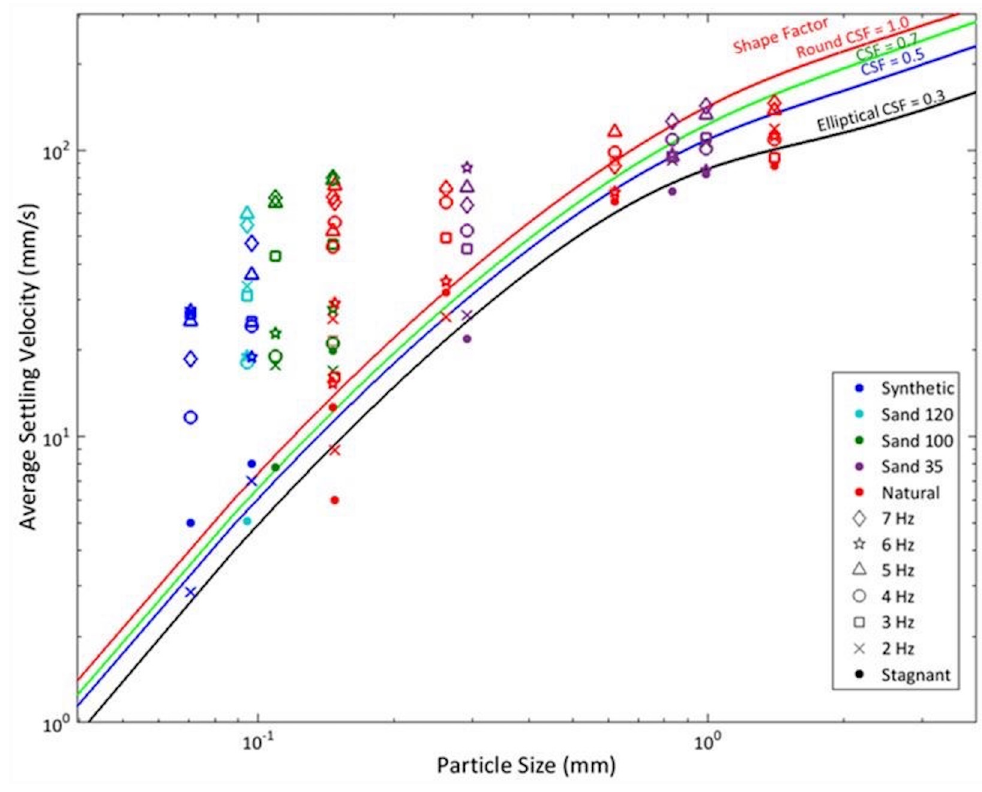
Fig 8. Settling velocities in stagnant and turbulent flow conditions versus particle size. The empirical curves of Dietrich [6] for particle settling velocity in stagnant water are also shown for